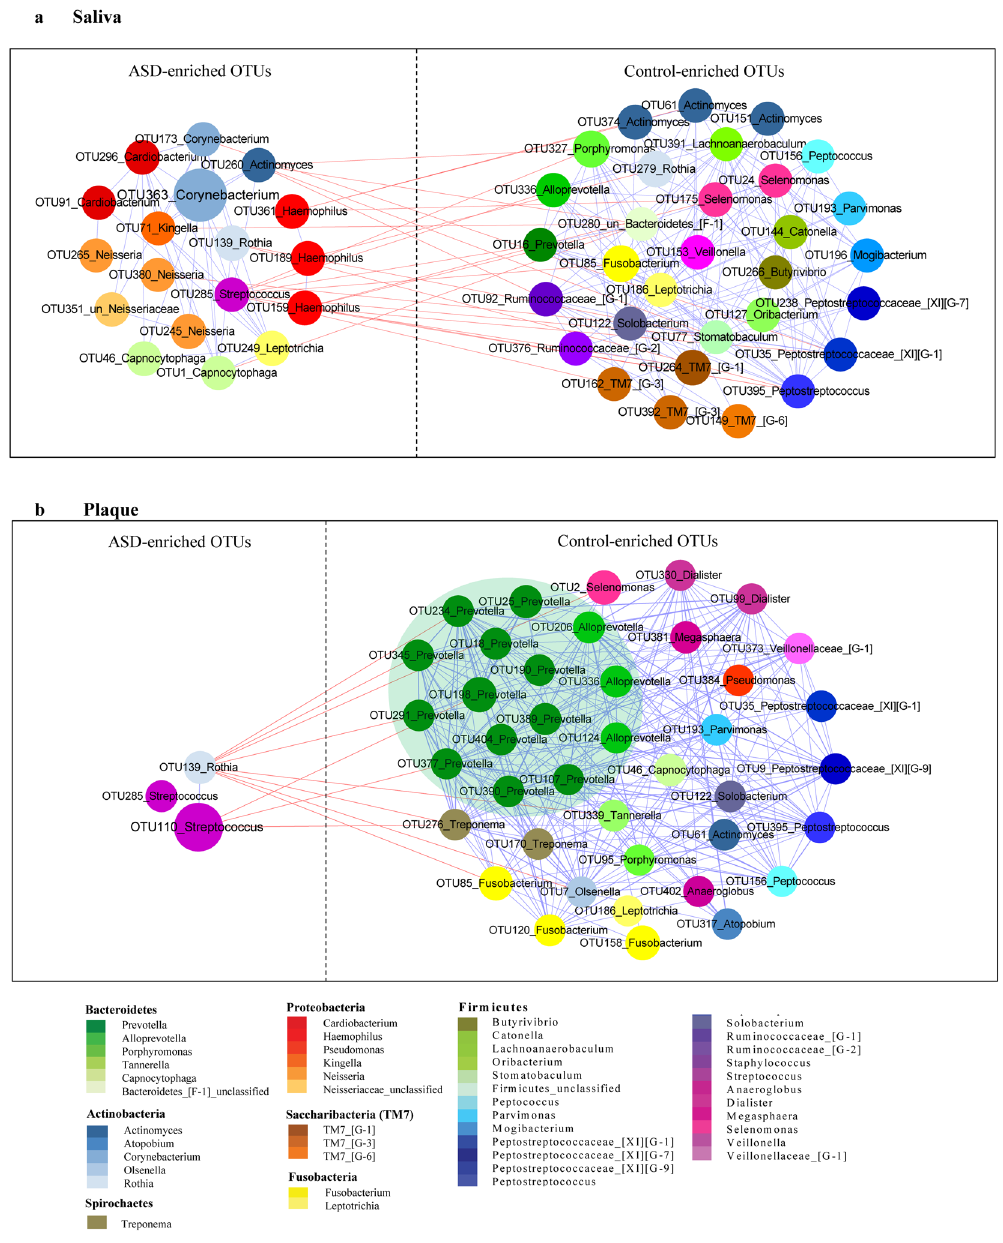
Figure 4. OTUs enriched in salivary and dental samples in ASD patients and healthy controls. A co-occurrence network was deduced from 53 OTUs in salivary samples ( a ) and 43OTUs in dental samples ( b ). Nodes depict OTUs with IDs and affiliated genus names displayed in the center. The size of the nodes indicates the abundance of each OTU. The color of a node indicates its taxonomic assignment. Connecting lines represent Spearman correlation coefficients above 0.5 (blue) or below − 0.5